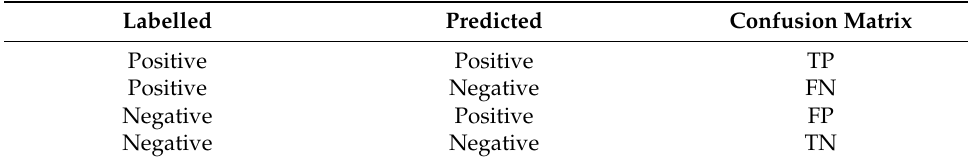
Table 4. Confusion matrix for the classification results.